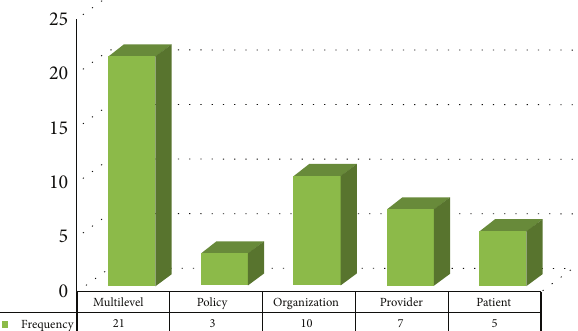
Figure 5: Frequencies for the level of measurement for the evalua- tion of intervention study